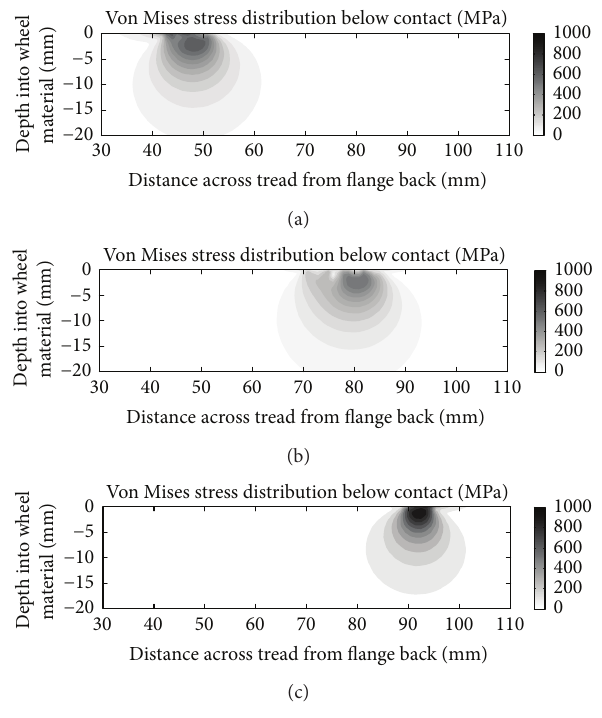
Figure 6: (a) Typical subsurface stress field in the flange root, Region C. (b) Typical subsurface stress field in the running band, Region D. (c) Typical subsurface stress field in the RCF band, Region